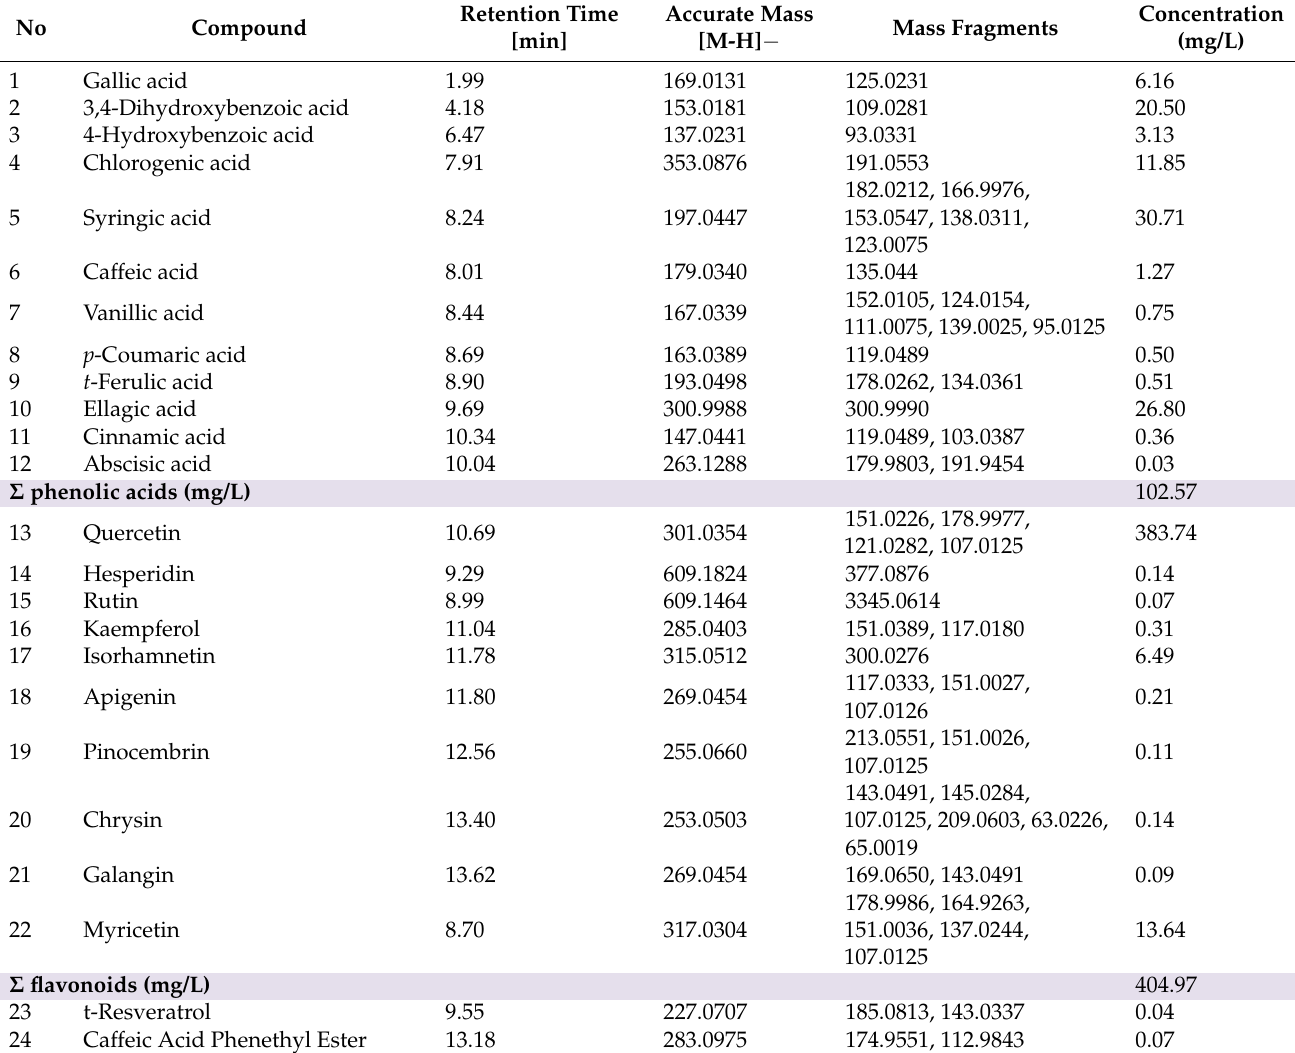
Table 2. Identification and quantitative data regarding the bioactive compounds in the T. erecta extract in negative ionization